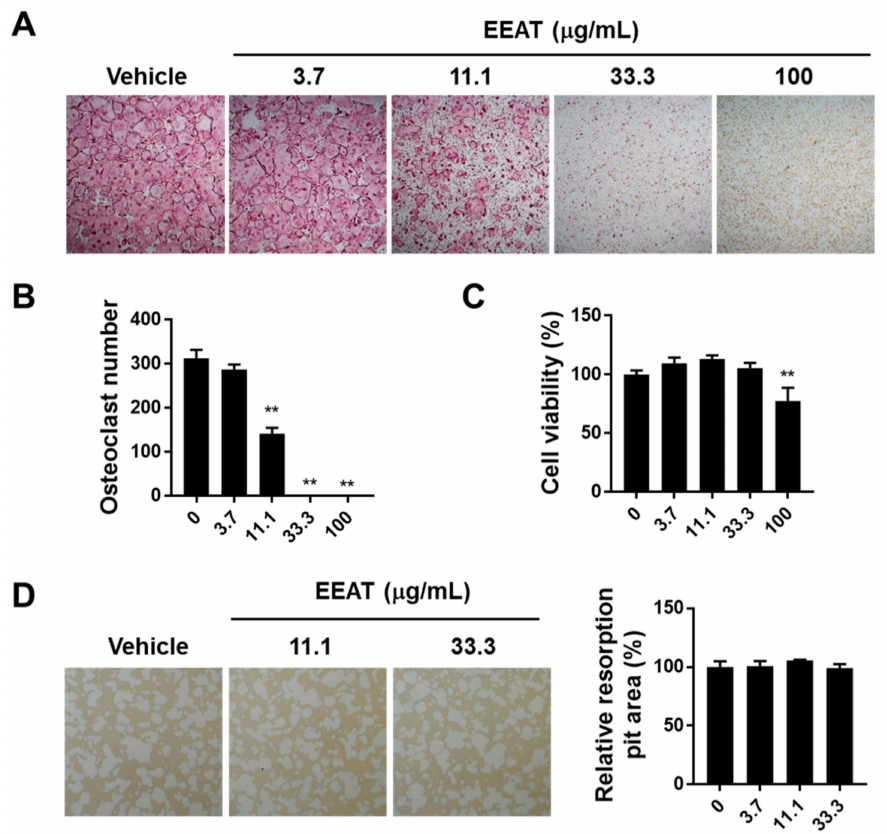
Figure 1. Ethanol extract of Amomum tsao-ko (EEAT) inhibits osteoclastogenesis in bone marrow- derived macrophage cells (BMMs) stimulated with receptor activator of nuclear factor-kappa B ligand (RANKL). ( A ) BMMs were differentiated to osteoclasts in the presence of macrophage colony- stimulating factor (M-CSF) and RANKL for four days. Vehicle or EEAT were treated in the culture medium at day 0. Generated osteoclasts were stained with tartrate-resistant acid phosphatase (TRAP) staining solution and photographed under a microscope ( × 4). ( B ) After TRAP staining, multinuclear osteoclasts were enumerated under the microscope ( × 4). ( C ) BMMs were incubated with M-CSF and the indicated concentrations of EEAT for 24 h and then assayed with CCK-8 solution to measure cell viability. ( D ) Mature osteoclasts were incubated with EEAT on the artificial bone surface to evaluate its effect on resorption activity. Resorption pits were photographed and analyzed. ** p < 0.01 versus